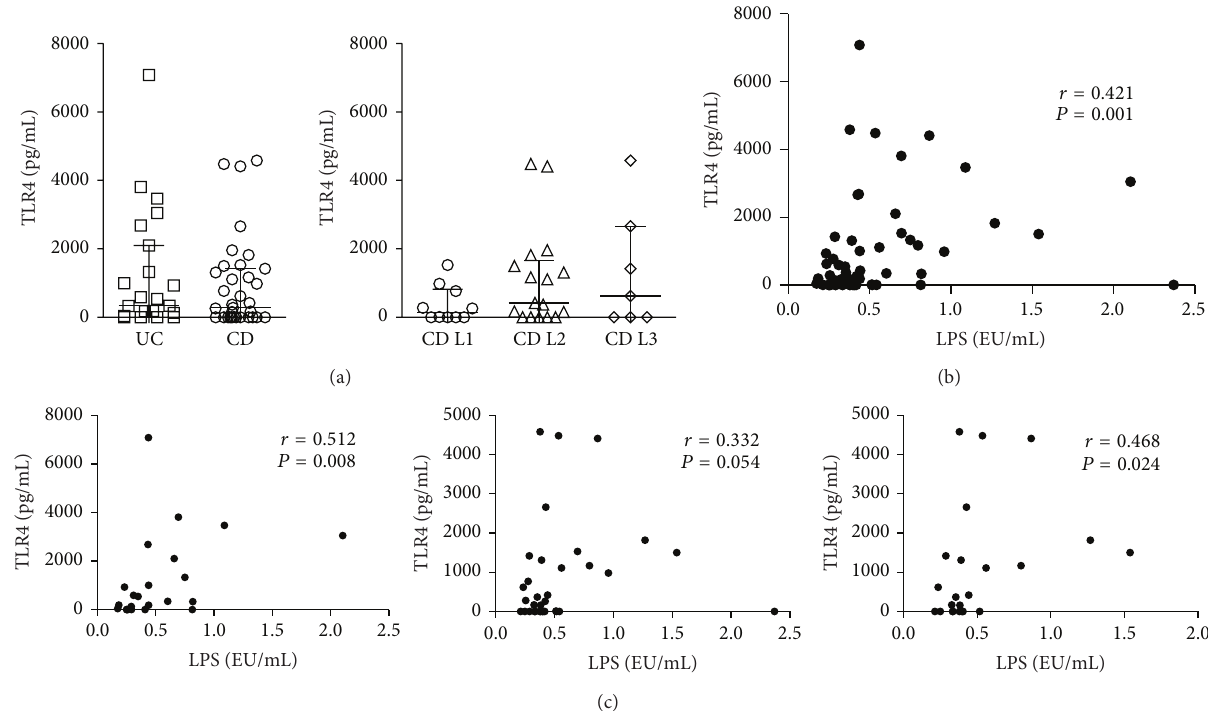
Figure 2: TLR4 serum correlates with circulating LPS in IBD patients. Concentrations of LPS and TLR4 were measured in the sera of IBD (both UC and CD) patients. (a) TLR4 serum levels in UC and CD patients (left panel) and CD locations according to Montreal classification (right panel). (b) Correlation between circulating levels of LPS and TLR4 in IBD patients. (c) Correlation between circulating levels of LPS and TLR4 in UC (left panel), CD (central panel) patients, and CD patients with colonic and ileocolonic involvement (L2 + L3 according to Montreal classification) (right panel). Horizontal bars in (a) represent median and interquartile range. Statistical analysis was performed by means of Spearman Correlation Test. 𝑃 < 0.05 was considered statistically